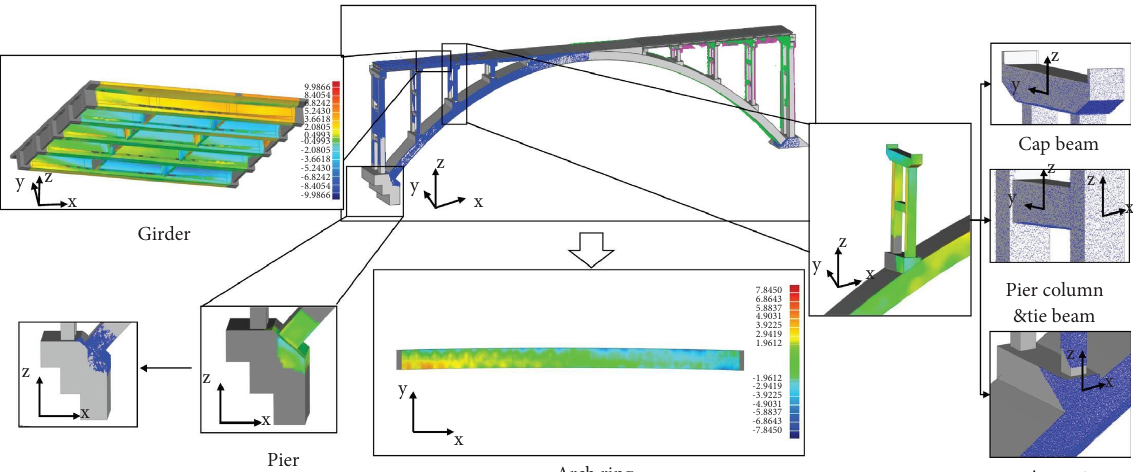
Figure 11: Deviation chromatogram of the arch bridge components, unit: mm.